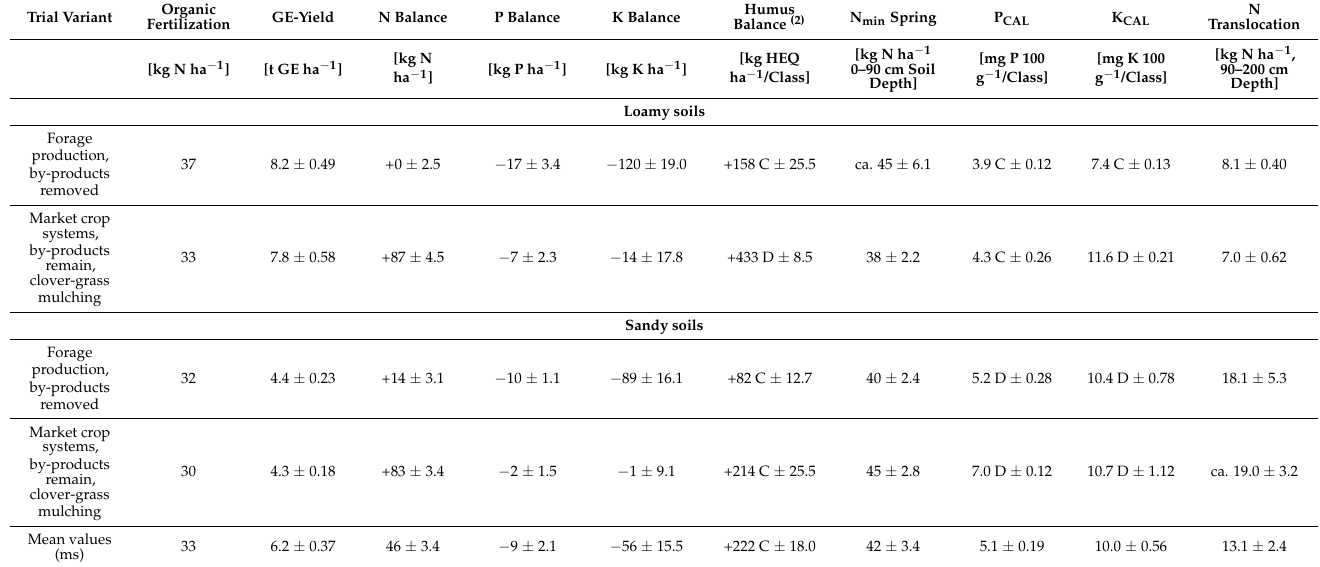
Table 2. Mean values, standard deviation (s), and supply classes (1) of some important characteristics of fertilization and soil fertility of forage and market crop systems with legumes around 33% in rotations and fertilization around 0.5 LU ha − 1 on loamy and sandy